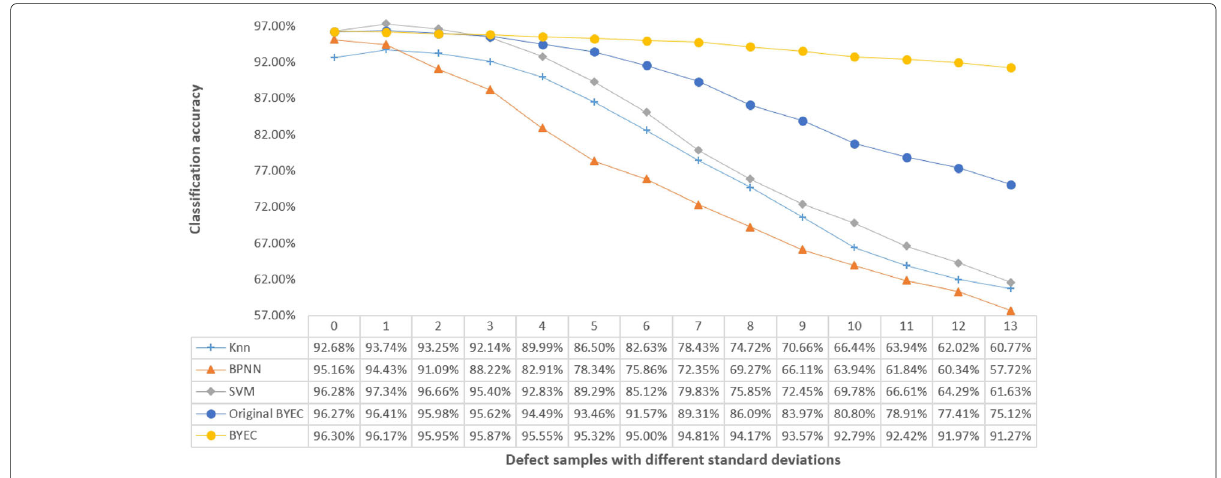
Fig. 8 Accuracy of different classifiers on the defect samples with different standard deviations ( 0 − 13 )